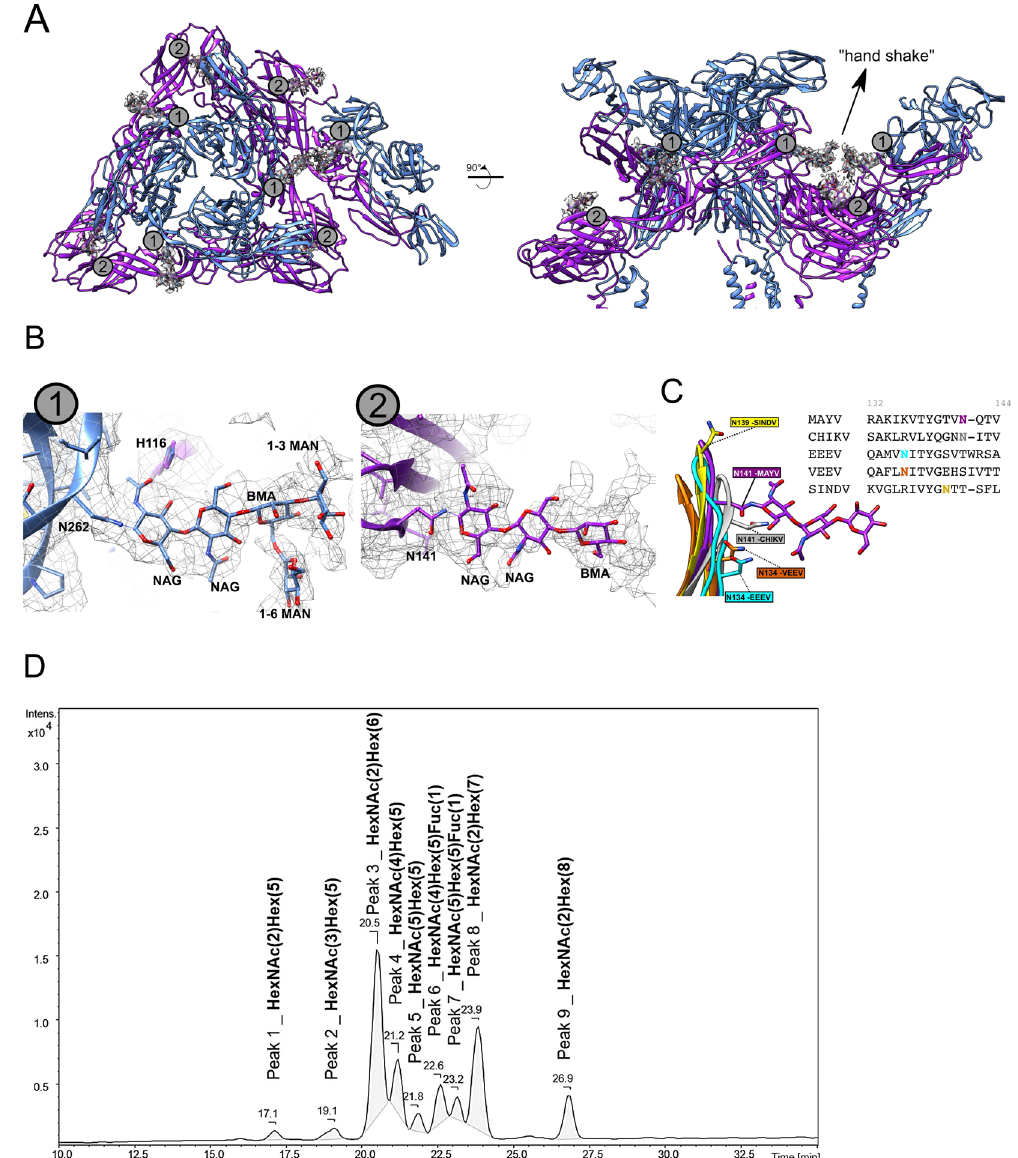
Fig. 4 N-Glycosylation sites observed in the E1 – E2 ectodomain of the MAYV cryo-EM structure. A E1 (N141) and E2 (N262) N-glycosylation sites. B On the left, zoom at the E2 N262 glycosylation with the carbohydrate monomers modelled. Polar residues under hydrogen bond distances are shown in sticks and labelled. On the right, detail of the E1 N141 site with the carbohydrates modelled. C Equivalent asparagine residues regions found in EEEV (cyan), VEEV (orange), SINDV (yellow) and CHIKV (grey) cryo-EM structures are shown superposed to the MAYV structure. MAYV density map is in mesh representation. D Base peak chromatogram derived from UPLC-MS/MS analyses of N-glycans released from E1/E2 glycoproteins of MAYV. Nine peaks were integrated (#1 to #9), being further characterized based on the MS1 isotopic and MS2 fragmentation patterns as N-glycans composed by combinations of N-acetyl-hexosamine (HexNAc); hexoses (Hex) or fucose (Fuc) as indicated. GlcNAc (NAG) and Man (MAN) were assigned as the hexosamine and hexose monomers based on enzyme PNGase F and EndoH speci fi city and cryo-EM density map